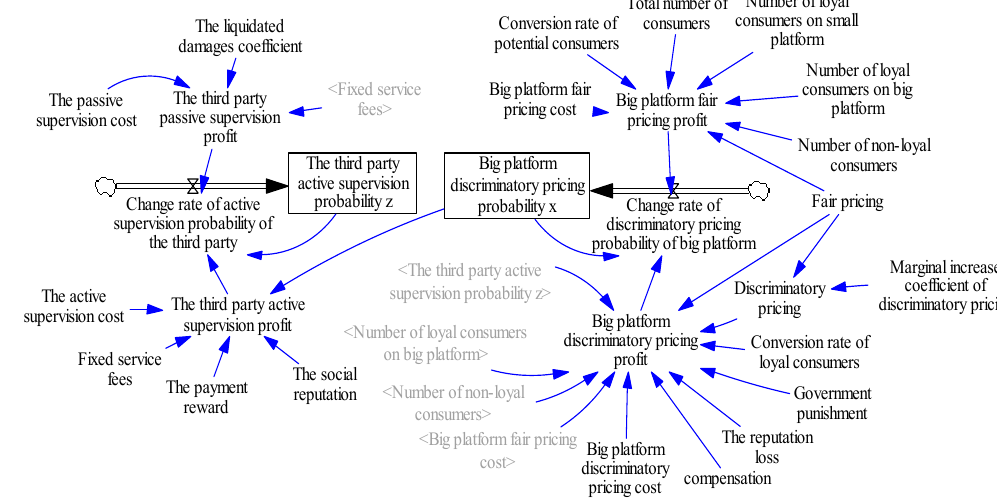
Figure 9. The System Dynamics model with the collaborative supervision mechanism of the government and the third party.